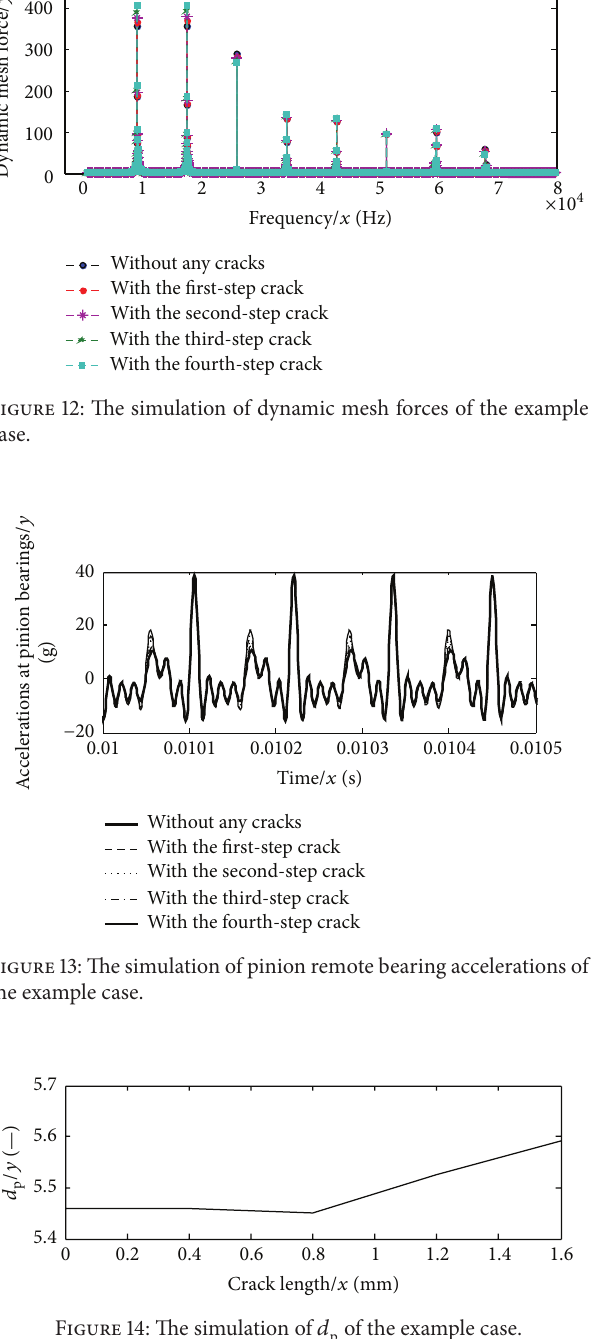
Figure 14: The simulation of 𝑑 p of the example